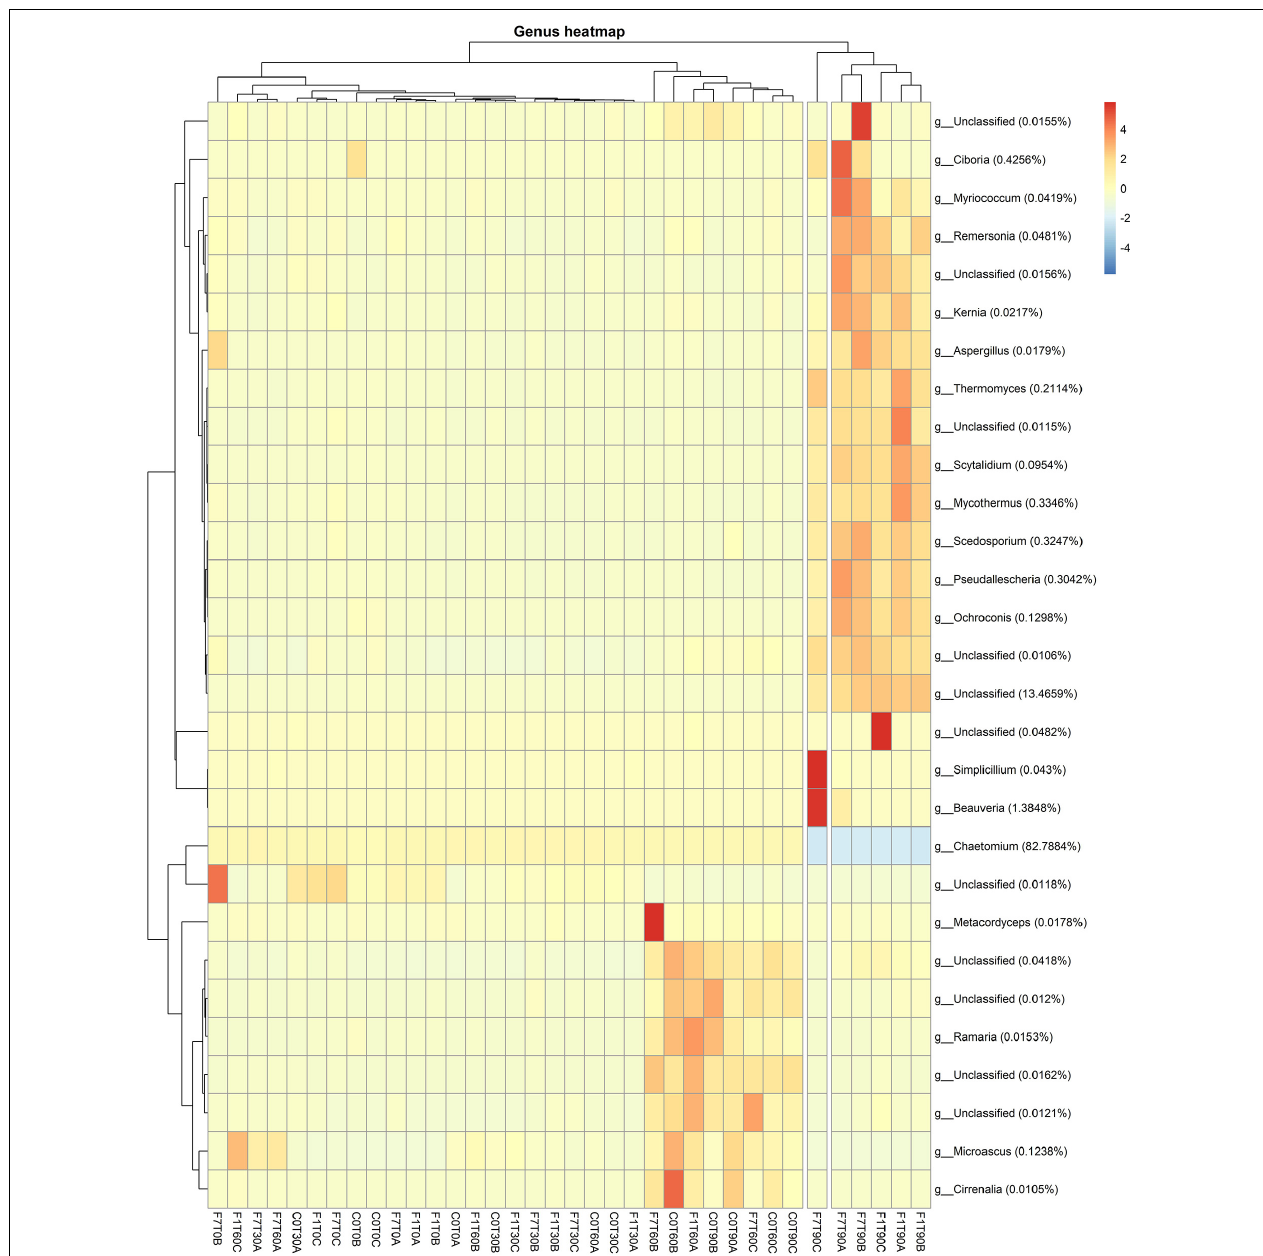
FIGURE 7 | Heatmaps showing fungal ASV abundances per sample at genus level with a cut-off of 0.01%. Hierarchical clustering was performed on both rows and columns by Pearson correlation, based on Euclidean distance. Color scheme represents row-wise Z-scores of ASV counts per sample. Percentage reported near ASV names represents the relative abundance of the sum of ASV counts per sample against total sum (i.e., Z = 0 matches reported percentage). Unclassified groups were not pooled.